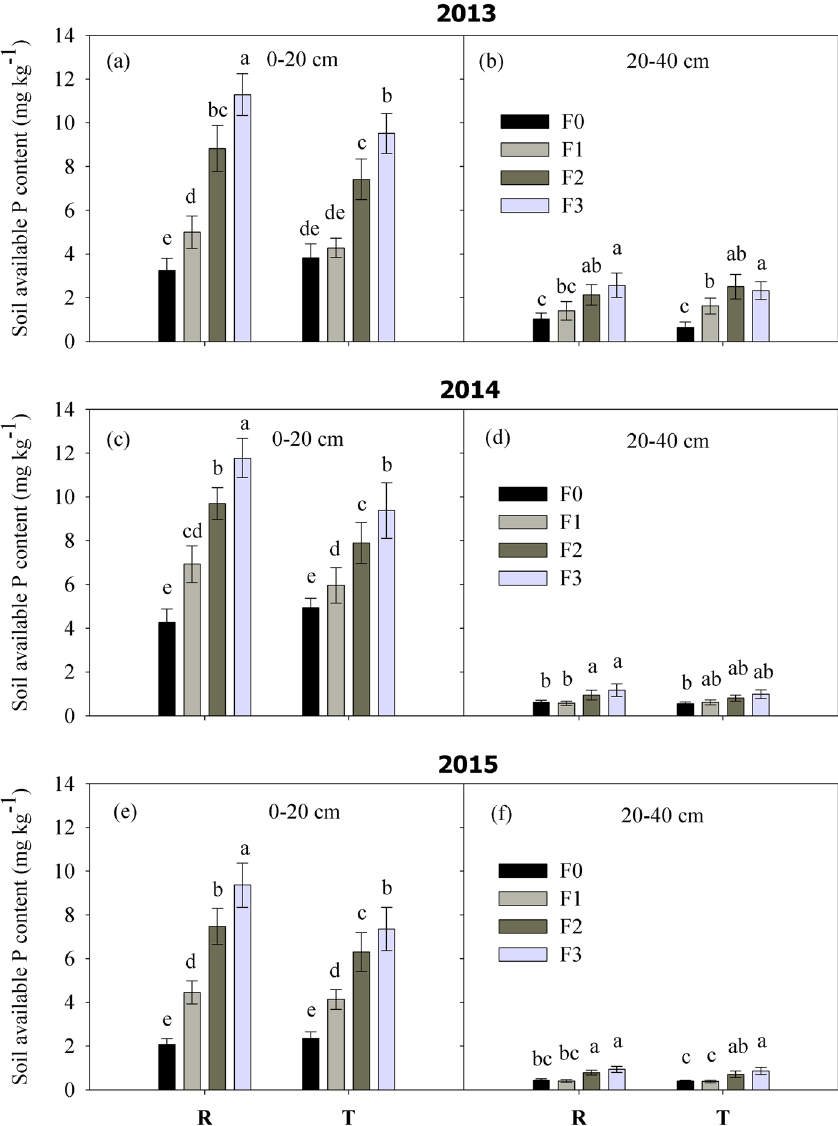
Figure 4. Soil available P contents in the 0–20 cm and 20–40 cm soil layers after harvest according to the fertilizer rate and planting pattern during 2013–2015. Note: R = ridge and furrow rainfall harvesting planting; T = traditional flat planting; F0, F1, F2, and F3 represent N:P at 0:0, 93:48, 186:96, and 279:144 kg ha − 1 , respectively. Different letters indicate significant differences at the P = 0.05